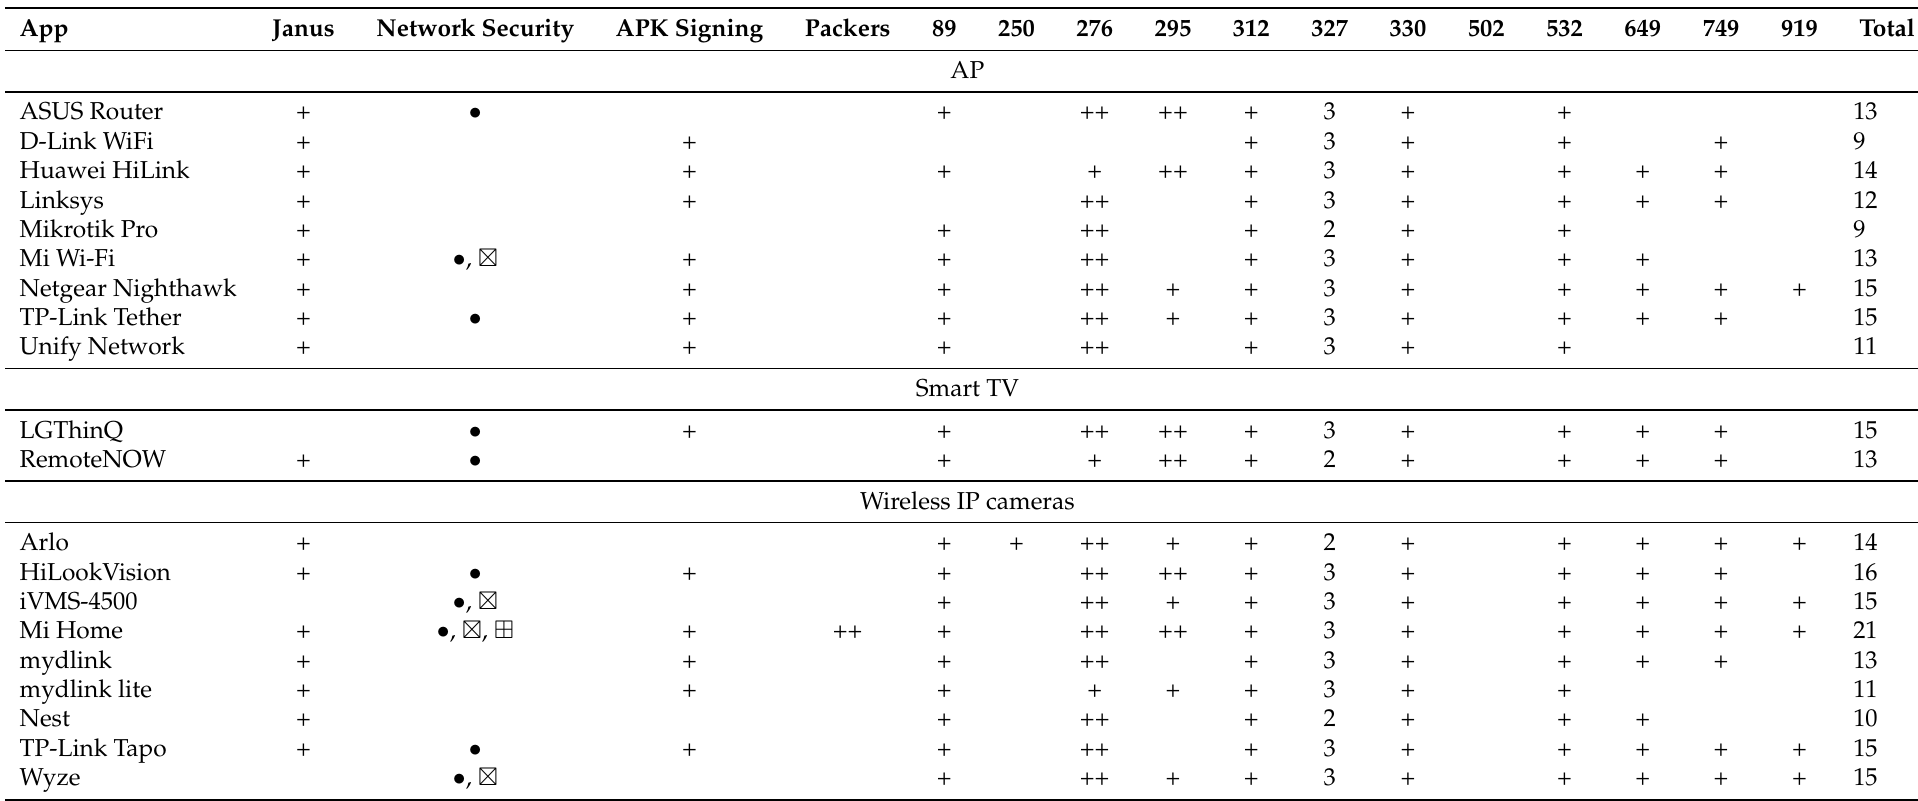
Table 3. Identified weaknesses and other security issues per examined app. The • , (cid:126) , (cid:2) , (cid:1) , and (cid:0) symbols in the third column denote “cleartext traffic to